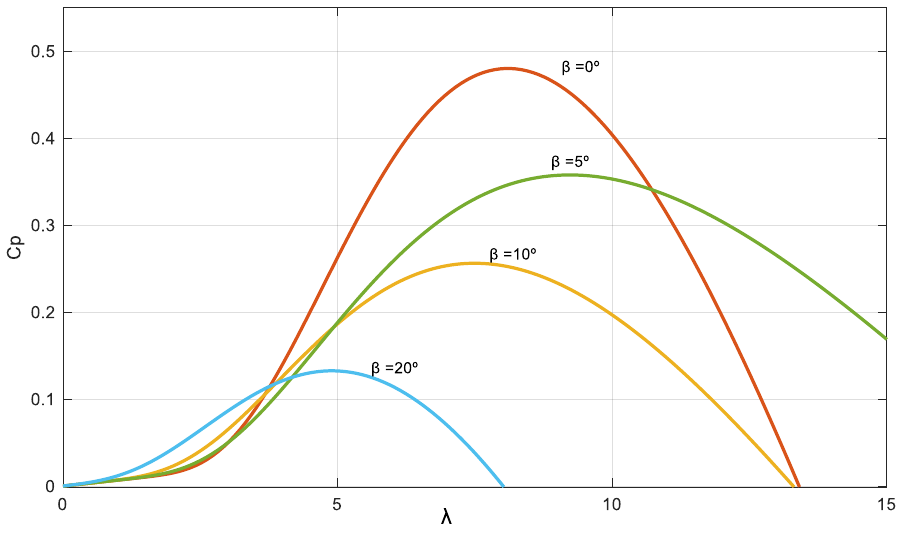
Figure 2. Variation of the 𝝀 - 𝑪 𝒑 curve depending on the pitch angle of the blades ( 𝜷 ).